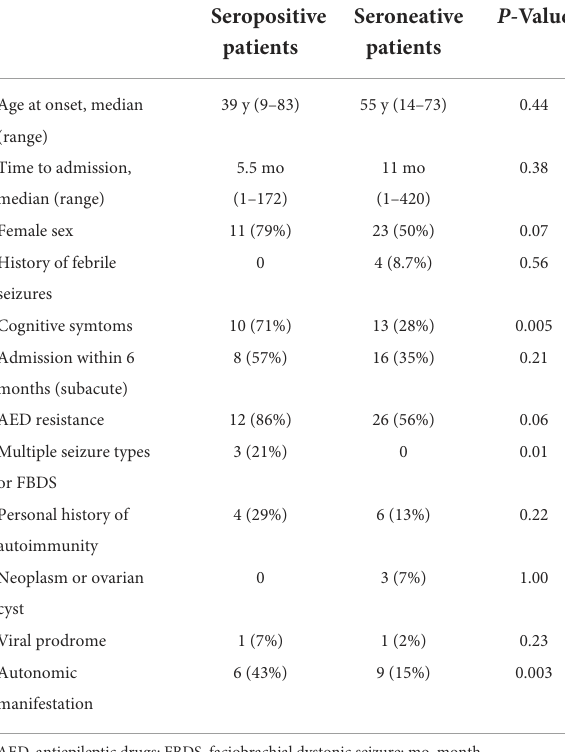
TABLE 1 Demographic clinical data of the patients. TABLE 2 Laboratory data of the